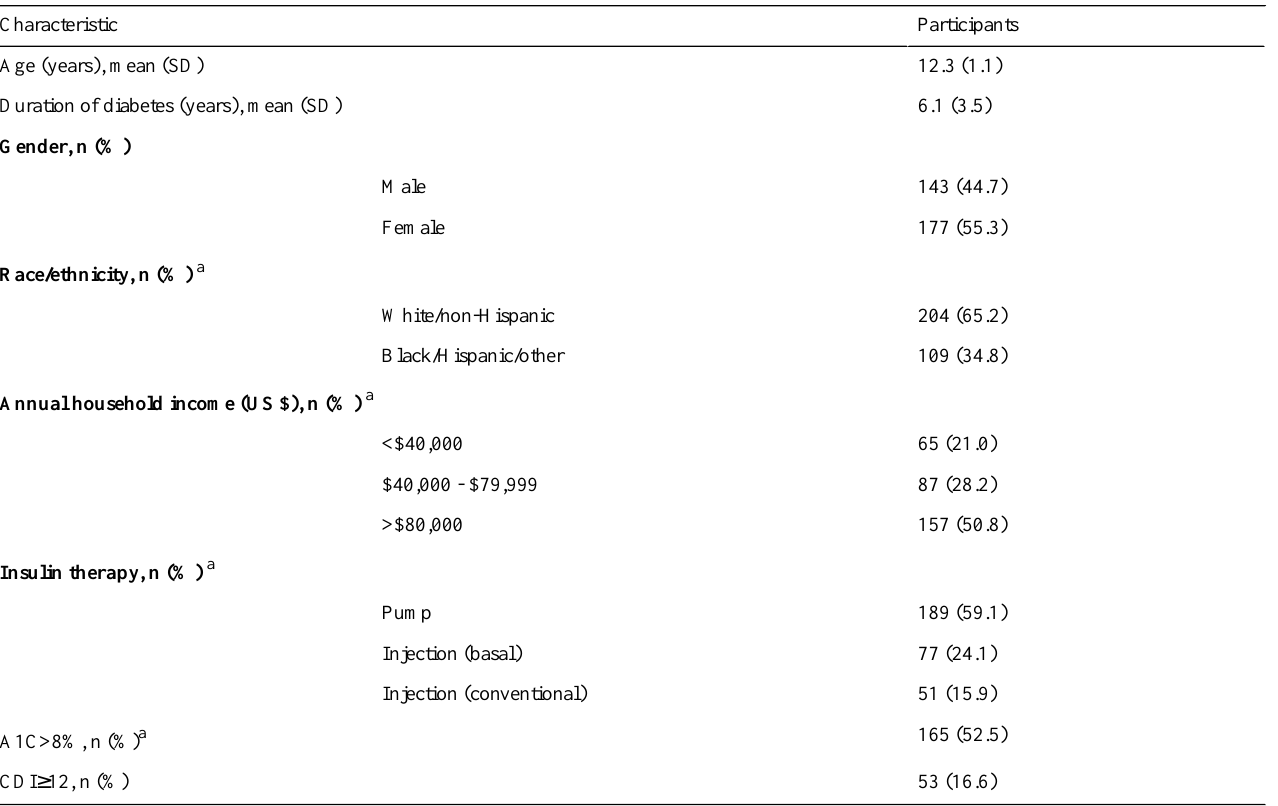
Table 1. Sample demographics of teen participants